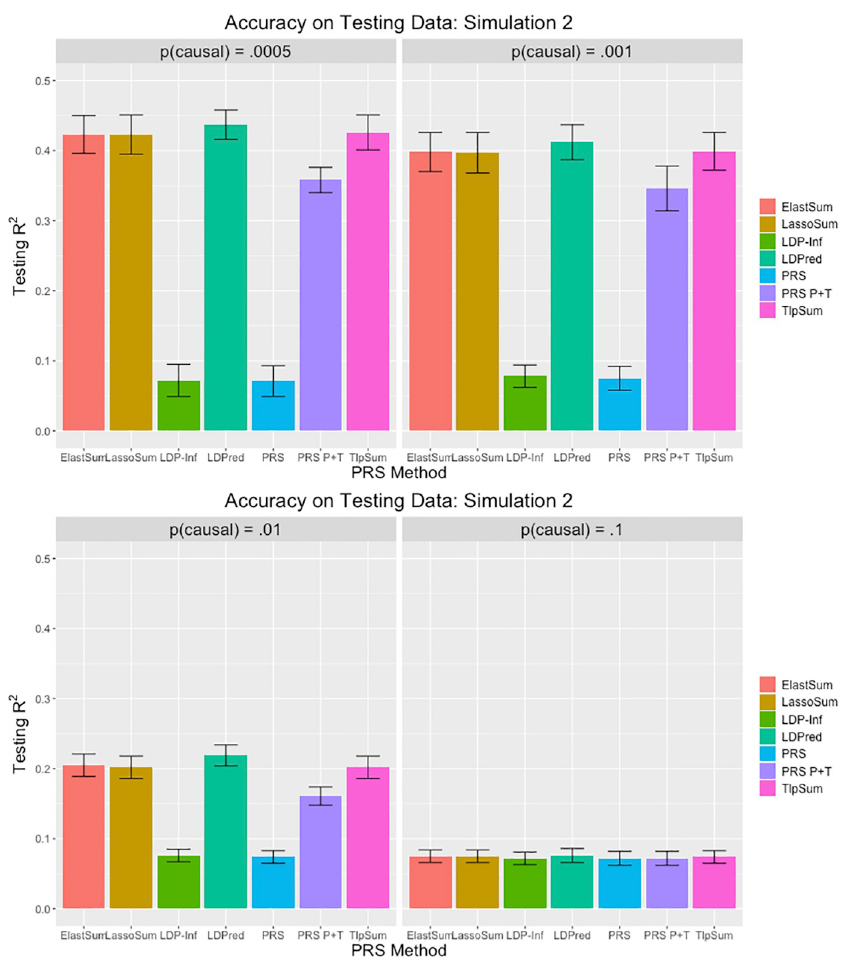
Fig 2. Prediction r 2 values for simulation 2. Error bars represent standard deviation for the r 2 value across 20 replications.